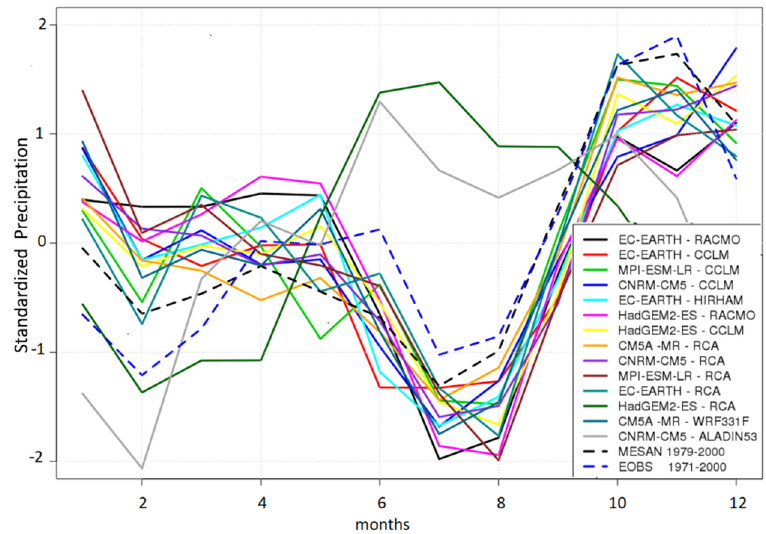
Figure 2. Seasonal cycle of precipitation according to the 14 Euro–CORDEX simulations (colored lines) in comparison with E-OBS and MESAN data (blue and black dashed lines, respectively), calculated for the period 1971–2000 (MESAN data refer to the 1979–2000 years) [31].